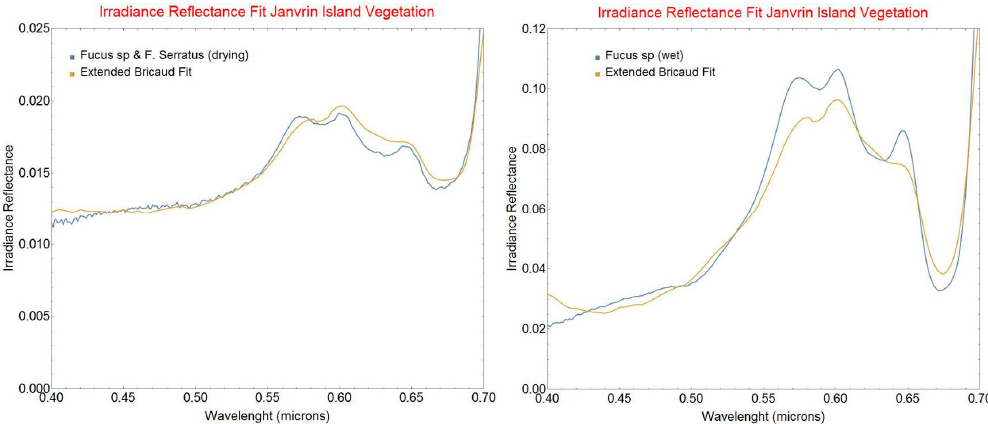
Figure 7. Comparison of modeled irradiance reflectance spectrum of wet Fucus sp. and a drying mixture of Fucus sp. and F. serratus (yellow curves) with the experimental measurements (blue curves). Note the noise degradation of the instrumental signal in the blue wavelength range. This reduced sensitivity may explain part of the incipient discrepancy in that spectral region.